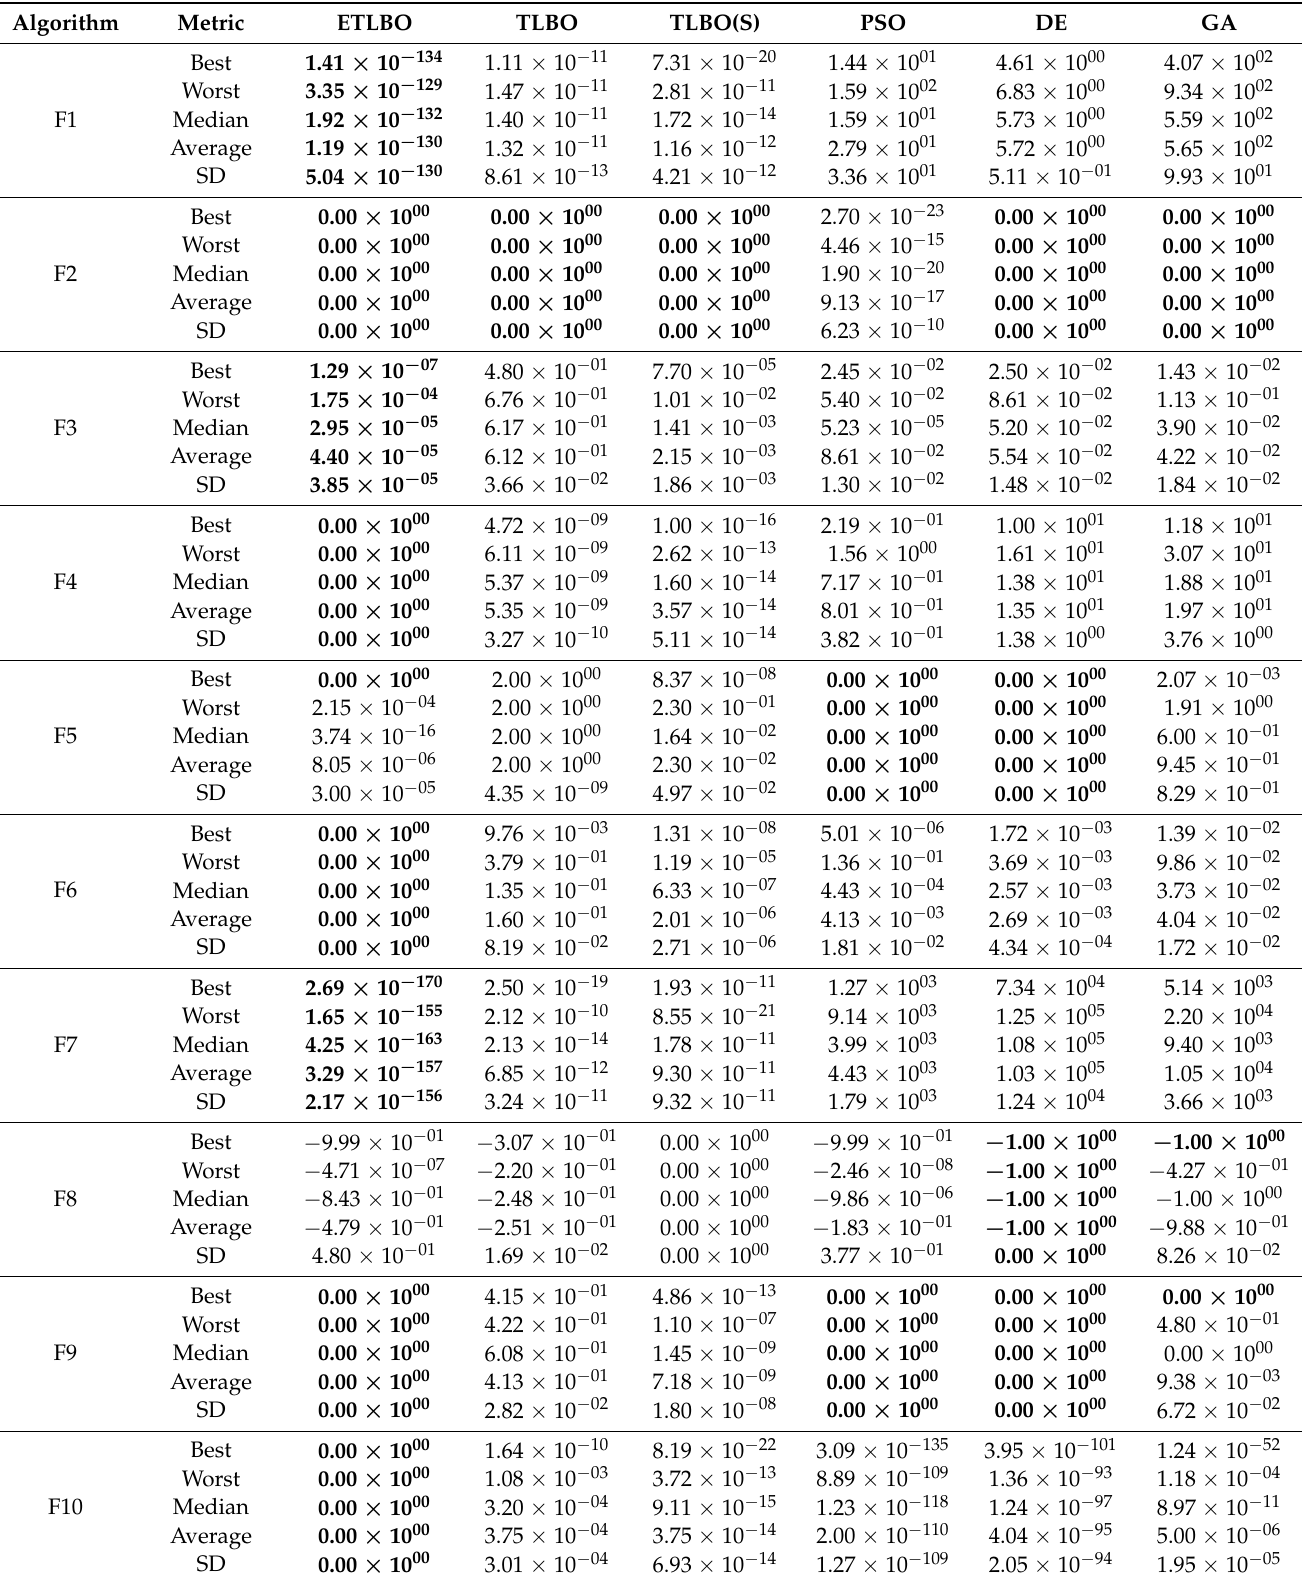
Table 3. Simulation results of unimodal